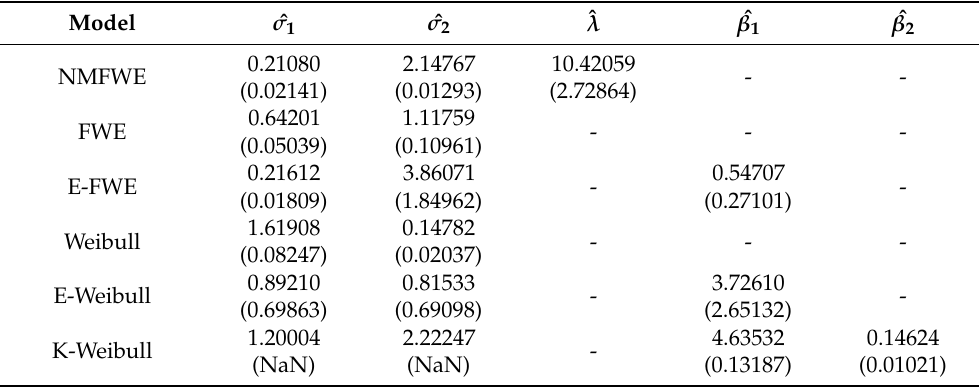
Table 7. The numerical values of ˆ σ 1 , ˆ σ 2 , ˆ λ , ˆ β 1 , and ˆ β 2 , using the second COVID-19 dataset.